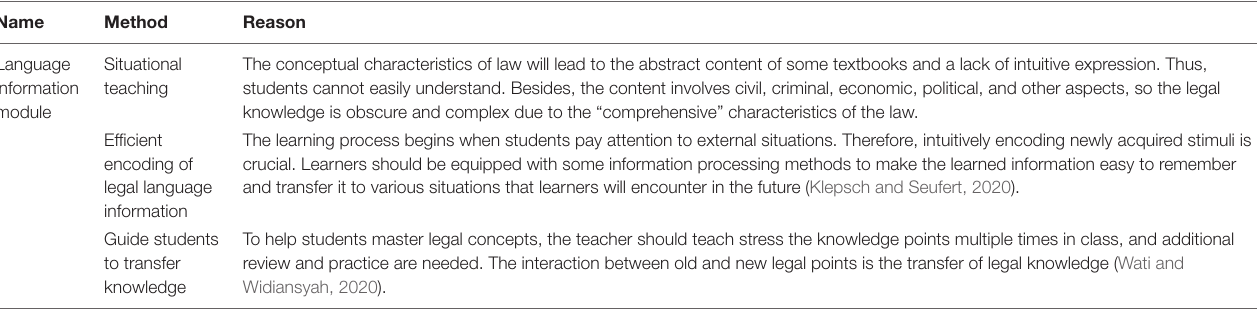
TABLE 2 | Contents of wisdom skills